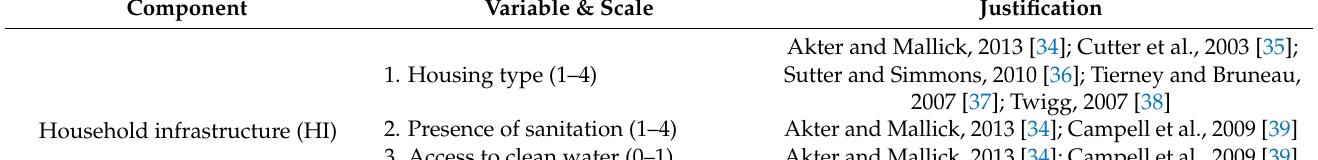
Table 1. Variables selected to measure the four dimensions of household cyclone resilience.